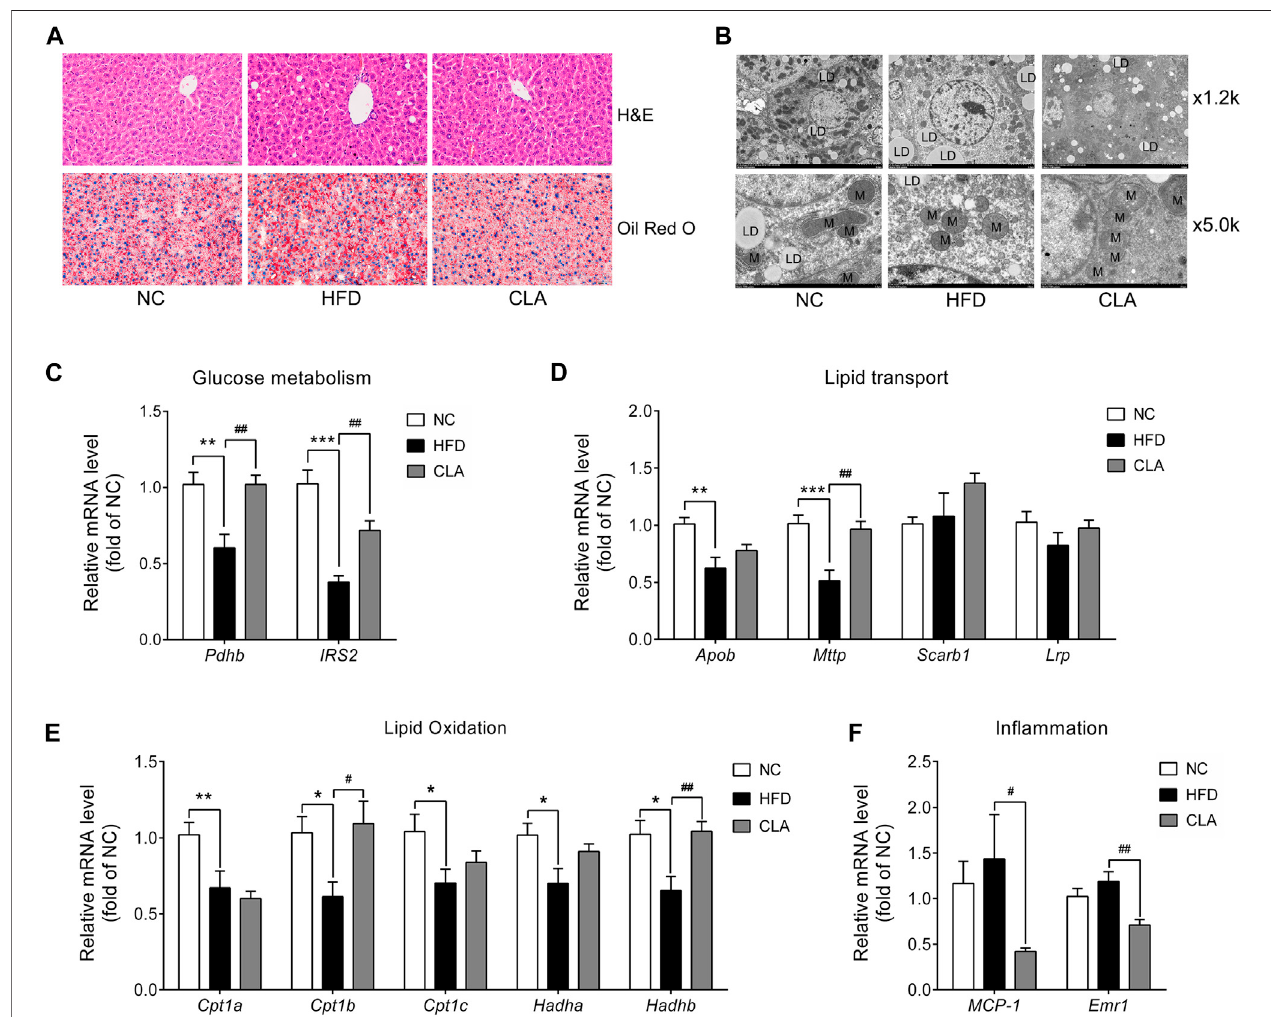
FIGURE 7 | Effects of CLA on the livers of HFD-induced mice. (A) Representative H and E staining (above) for histopathology and oil red O staining (below) for the detection of triglycerides (red color) of the liver sections. Original magni fi cation, × 400. Scale bar, 20 μ m. (B) Representative transmission electronic microscopy images of the liver. L, lipid droplet; M, mitochondria; original magni fi cation, × 1.2 k and × 5.0 k. Scale bar, 10.0 μ m. (C – F) Relative mRNA levels of genes involved in glucose metabolism, lipid transport, lipid β -oxidation, and in fl ammation normalized to β -actin ( n (cid:2) 7). * p < 0.05, ** p < 0.01, *** p < 0.001 vs. NC; # p < 0.05, ## p < 0.01 vs.